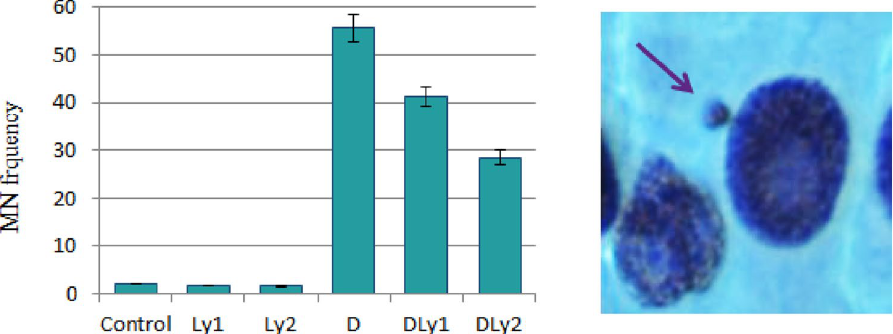
Figure 2. MN frequency and MN appearance induced by dithane. 1000 cells were scored for each group to evaluate MN